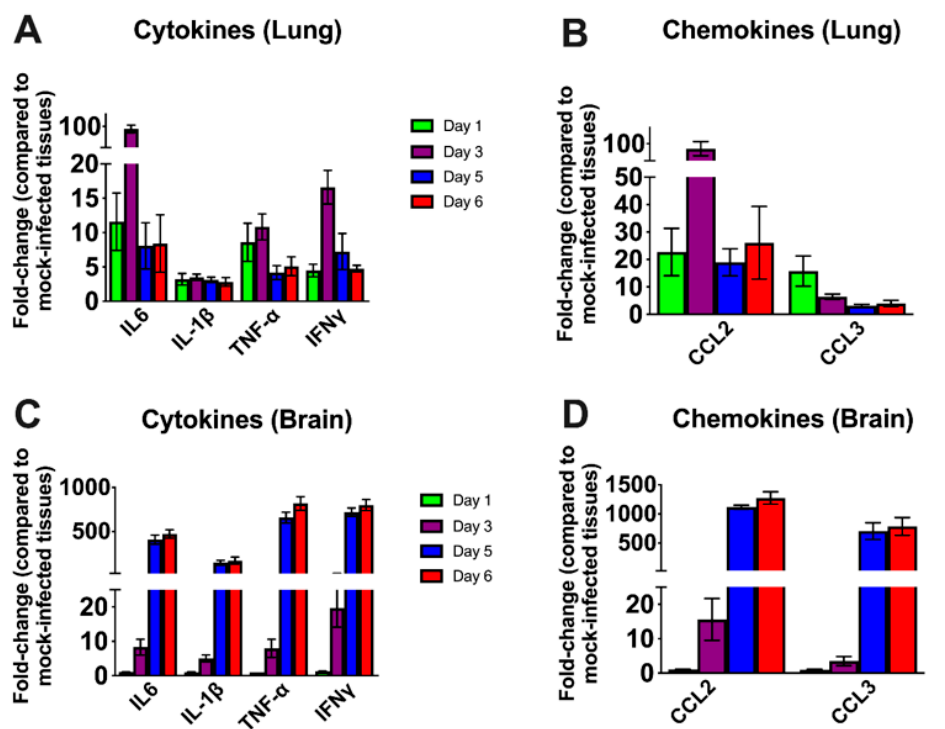
Figure 4. Cytokine and chemokine mRNA levels in the lungs and brain. The mRNA levels of various cytokine and chemokine genes were determined in the lungs ( A , B ) and brain ( C , D ) using qRT-PCR. Fold change in the infected tissues compared to the corresponding mock controls was calculated after normalizing to GAPDH mRNA in each sample. Error bars represent SEM ( n = 5 mice per group).